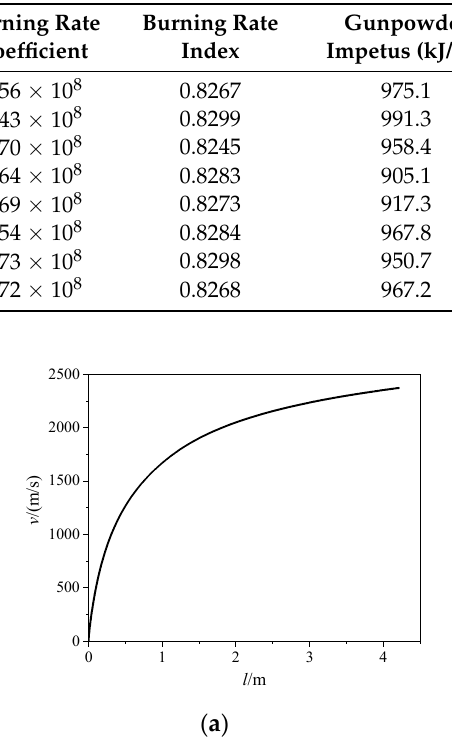
Table 4. Better optimization result.